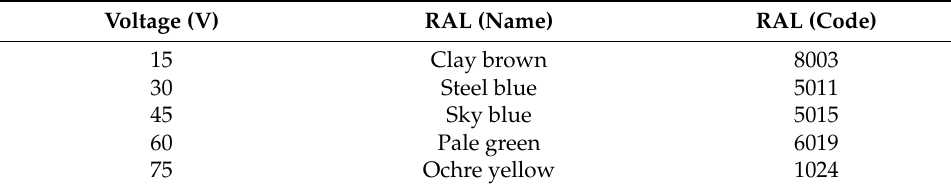
Figure 1. Color palette produced by anodic coloring at different voltages . Table 1. RAL codes for colors produced by each anodization voltage .